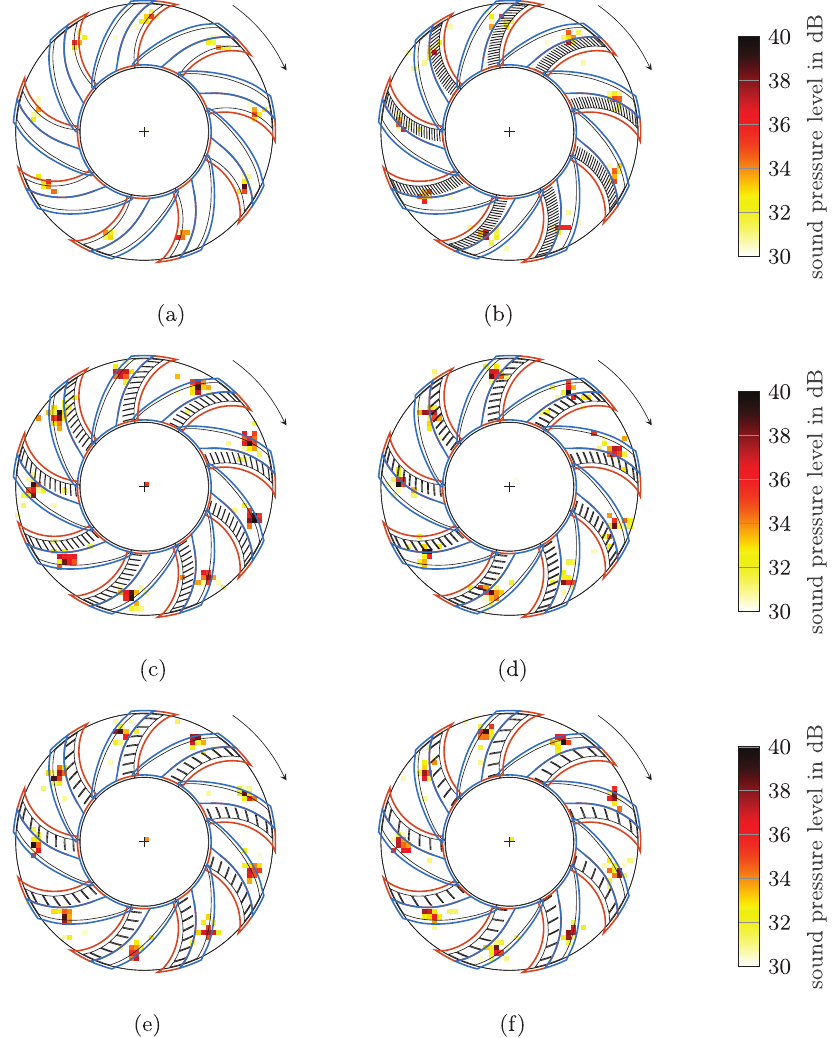
Figure 10. Acoustic source maps for the one-third octave band having a center frequency f c = 4 kHz evaluated with the ARM. The red marked area is the subregion of the leading edge and blue marked area is the subregion of the trailing edge. Volume fl ow rate _ V ¼ 1.1 m 3 s (cid:1) 1 and fan rotational speed f R = 24.8